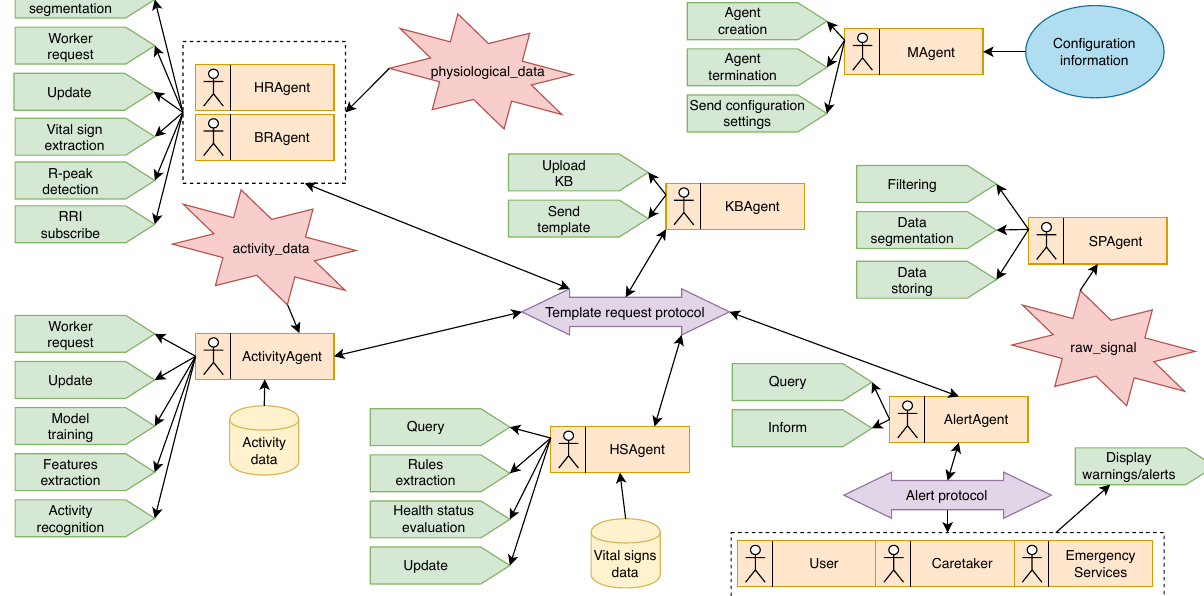
Figure 2. Proposed multi-agent